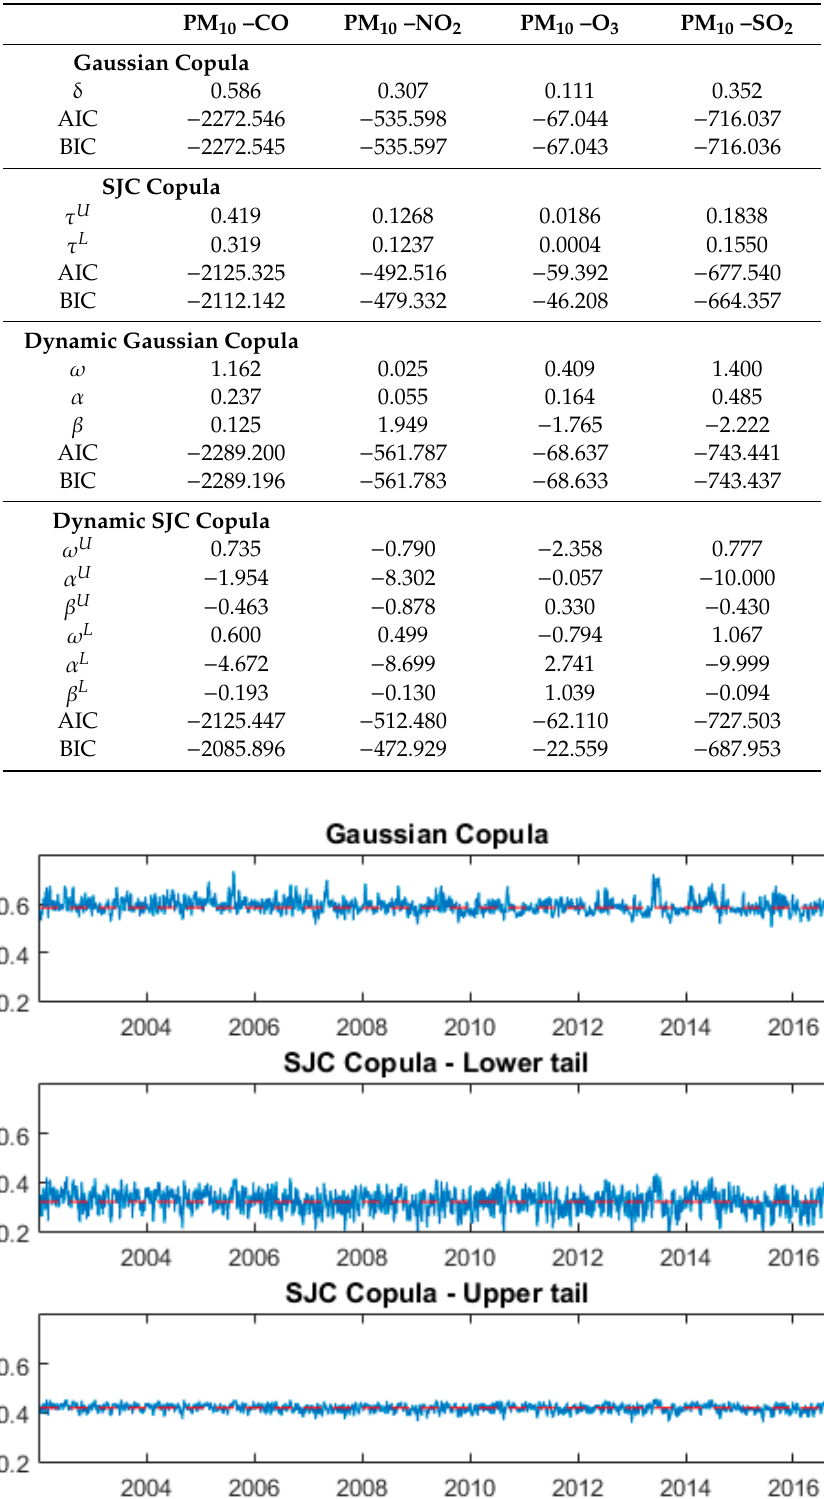
Figure 6. Dependence path of the time-varying copula for PM 10 -NO 2 .